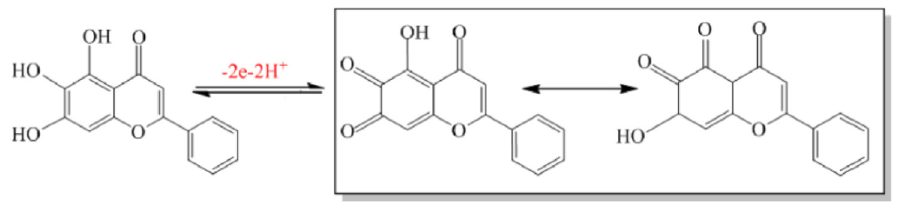
Figure 24. The redox mechanism of baicalein at Au–Pt@BPC/CILE. Reprinted with permission from [55], ©2020 Elsevier B.V.